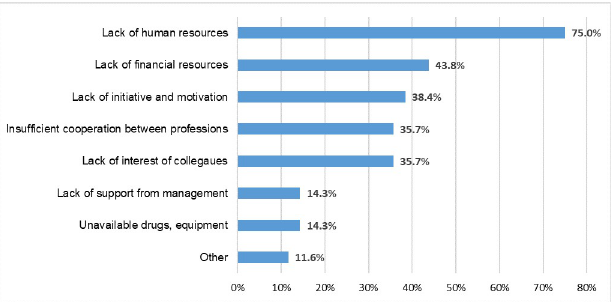
Fig 1. Barriers to the establishment of Acute Pain Services (APS) in Hungarian hospitals, based on the opinion of respondent health professionals (N = 112).